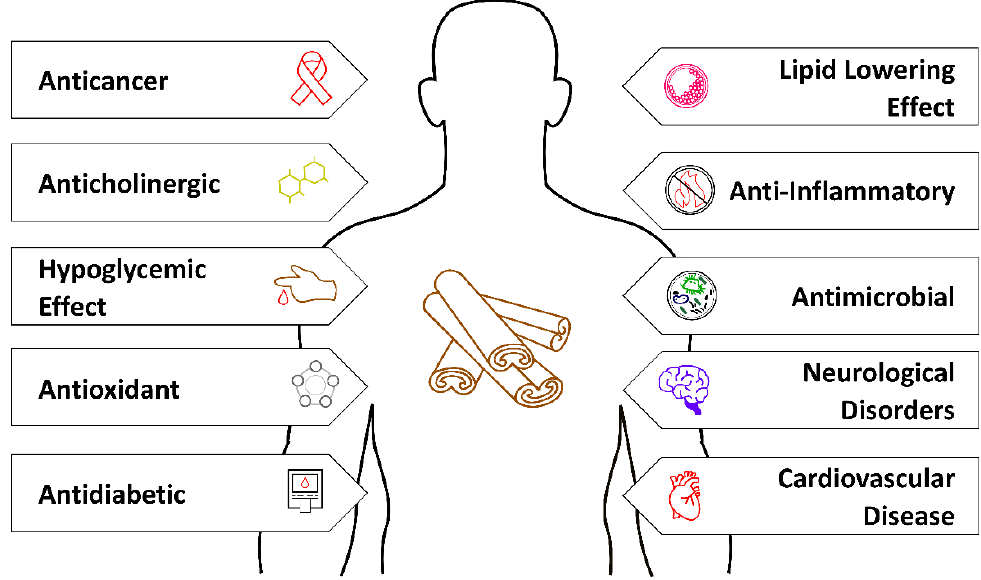
Figure 2. Cinnamon in the treatment of diseases and disorders [4,8,12,13,17,37,46 –